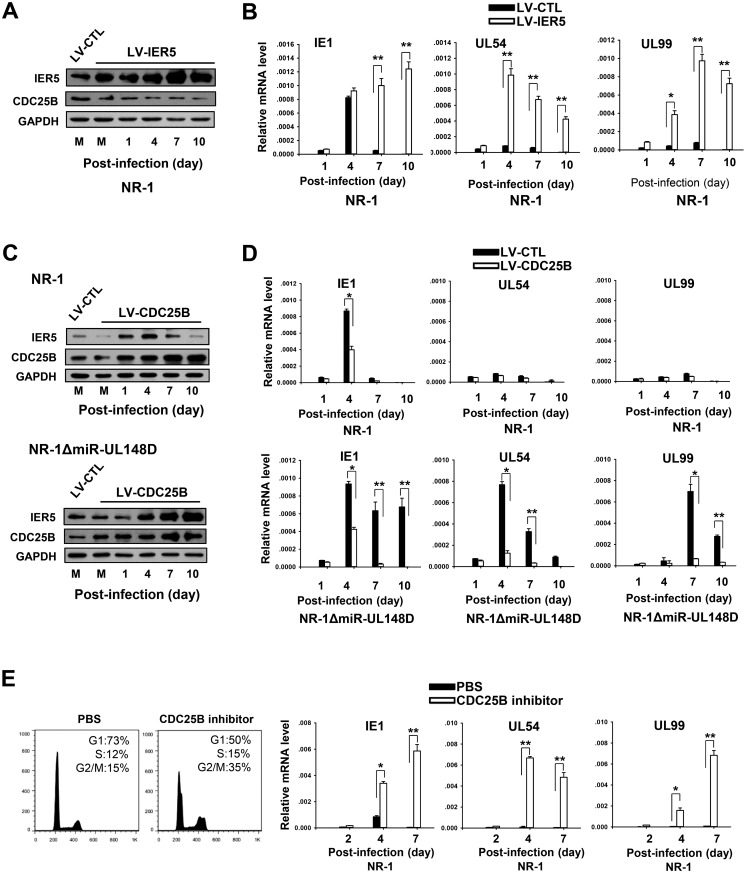
CDC25 expression is essential for silencing IE1 transcription.(A, B) Stable overexpression of IER5 induced viral lytic gene transcription in NR-1-infected Kasumi-3 cells. IER5 was stably overexpressed in Kasumi-3 cells infected with LV-IER5. An empty-backbone lentivirus was used as a control. The cells were then infected with NR-1 virus for a 10-day time course. The infected cells were analyzed for IER5 and CDC25B protein expression (A) and IE1 (immediately early), UL54 (early lytic transcript), and UL99 (late lytic transcript) mRNA expression (B). (C, D) Stable overexpression of CDC25B suppressed viral lytic gene transcription in NR-1ΔmiR-UL148D-infected Kasumi-3 cells. CDC25B was also stably overexpressed in Kasumi-3 cells infected with LV-CDC25B. An empty-backbone lentivirus was used as a control. The cells were then infected with NR-1 or NR-1ΔmiR-UL148D virus for a 10-day time course. IER5 and CDC25B protein expression (C) and IE1, UL54, and UL99 mRNA expression (D) were then measured in the Kasumi-3 cells. (E) Pharmaceutical inhibition of CDC25B efficiently induced viral lytic gene transcription in NR-1-infected cells. After infection with NR-1, Kasumi-3 cells were incubated with NSC663284, a specific CDC25B inhibitor, at a concentration of 5 μM for 48 hours. Then, the treated cells were further cultured in fresh media for 5 days. The DNA content in the treated cells was analyzed 2 dpi. Total RNA was extracted for RT-qPCR analysis of IE1, UL54 and UL99 expression at the indicated time points along a 7-day time course. Values are shown as the mean ± SEM (n = 3). **, P<0.01.